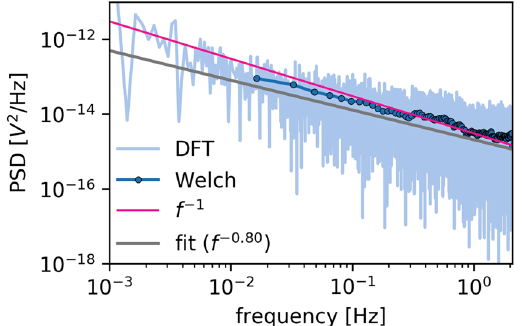
Figure 3. Power spectral density as a function of the frequency calculated for the currents was measured using the ELoPvC. PSD was calculated using the Welch method (blue circles) and shadowed by the results of the discrete Fourier transform (light blue in the background) manifest the 1/ f noise behaviour for more than four decades of frequencies (feature that is highly characteristic for the membrane ion channels), which is indicated by the straight pink line for the minimally stable region of the electromotive force. The actual fit, which resulted in a slightly different power law ( α = − 0.791 ± 1.779 ∙ 10 − 4 ), is indicated by a grey